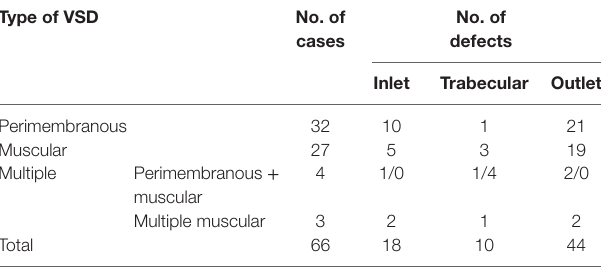
TaBle 5 | complete Tga: site of VsD. Type of VsD